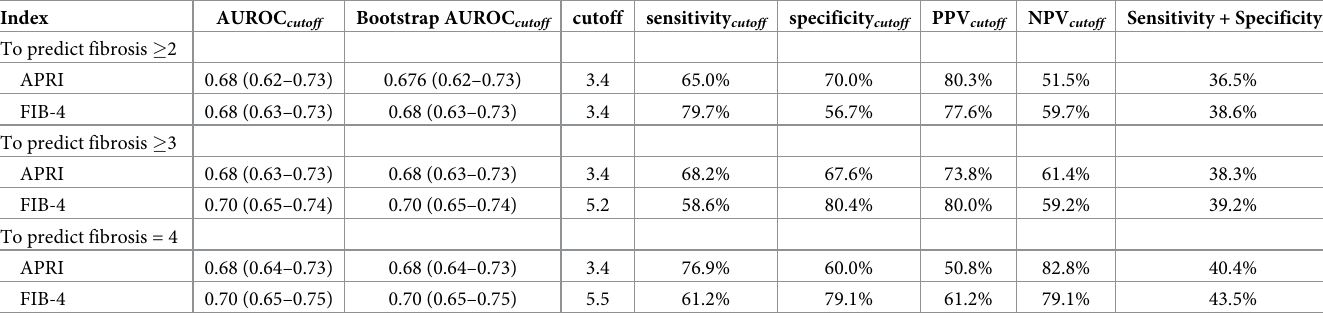
optimal cutoff values of APRI and FIB-4 for the diagnosis of (cid:21) F2, (cid:21) F3, and F4 were 3.4 and 3.4, 3.4 and 5.2, and 3.4 and 5.5, respectively, in patients with AST > 148 IU/L (Table 6). Comparison of diagnostic accuracy between APRI and FIB-4 A comparison of the ROC of APRI vs. that of FIB-4 to predict fibrosis (cid:21) 2 in patients with AST (cid:20) 37 IU/L is shown in S1 Fig, P = 0.11. A comparison of the ROC of APRI vs. that of FIB-4 to predict fibrosis (cid:21) 2 in patients with 37 < AST (cid:20) 74 IU/L is shown in S2 Fig, P = 0.86. A comparison of the ROC of APRI vs. that of FIB-4 to predict fibrosis (cid:21) 2 in patients with 74 < AST (cid:20) 148 IU/L is shown in S3 Fig, P = 0.11. A comparison of the ROC of APRI vs. that of FIB-4 to predict fibrosis (cid:21) 2 in patients with AST > 148 IU/L is shown in S4 Fig, P = 0.19. A comparison of the ROC of APRI vs. that of FIB-4 to predict fibrosis (cid:21) 3 in patients with AST (cid:20) 37 IU/L is shown in S5 Fig, P = 0.11. A comparison of the ROC of APRI vs. that of FIB-4 to predict fibrosis (cid:21) 3 in patients with 37 < AST (cid:20) 74 IU/L is shown in S6 Fig, P = 0.33. A comparison of the ROC of APRI vs. that of FIB-4 to predict fibrosis (cid:21) 3 in patients with 74 < AST (cid:20) 148 IU/L is shown in S7 Fig, P = 0.04. A comparison of the ROC of APRI vs. that of FIB-4 to predict fibrosis (cid:21) 3 in patients with AST > 148 IU/L is shown in S8 Fig, P = 0.13. A comparison of the ROC of APRI vs. that of FIB-4 to predict fibrosis = 4 in patients with AST (cid:20) 37 IU/L is shown in S9 Fig, P = 0.58. A comparison of the ROC of APRI vs. that of FIB-4 to predict fibrosis = 4 in patients with 37 < AST (cid:20) 74 IU/L is shown in S10 Fig, P = 0.21. A Table 6. Diagnostic accuracies of APRI and FIB-4 for predicting liver fibrosis (AST > 148 IU/L, N = 346). Index AUROC